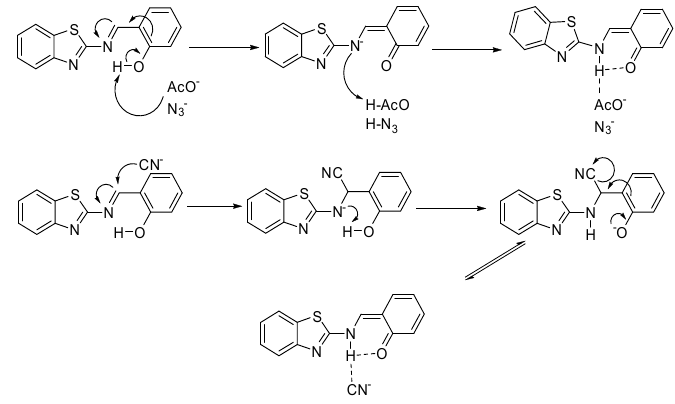
Figure 3. UV-vis spectra of the interaction of interaction of 1 ( a ) and 2 ( b ) with different anions in H 2 O/CH 3 CN